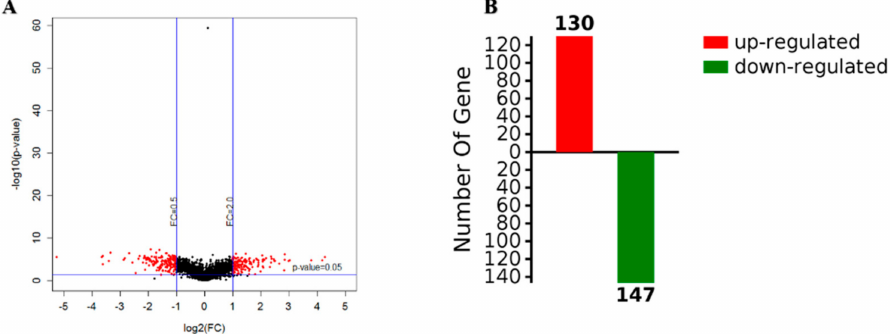
Figure 4. Volcanic maps of gene expression ( A ) and the number of upregulated and downregulated proteins ( B